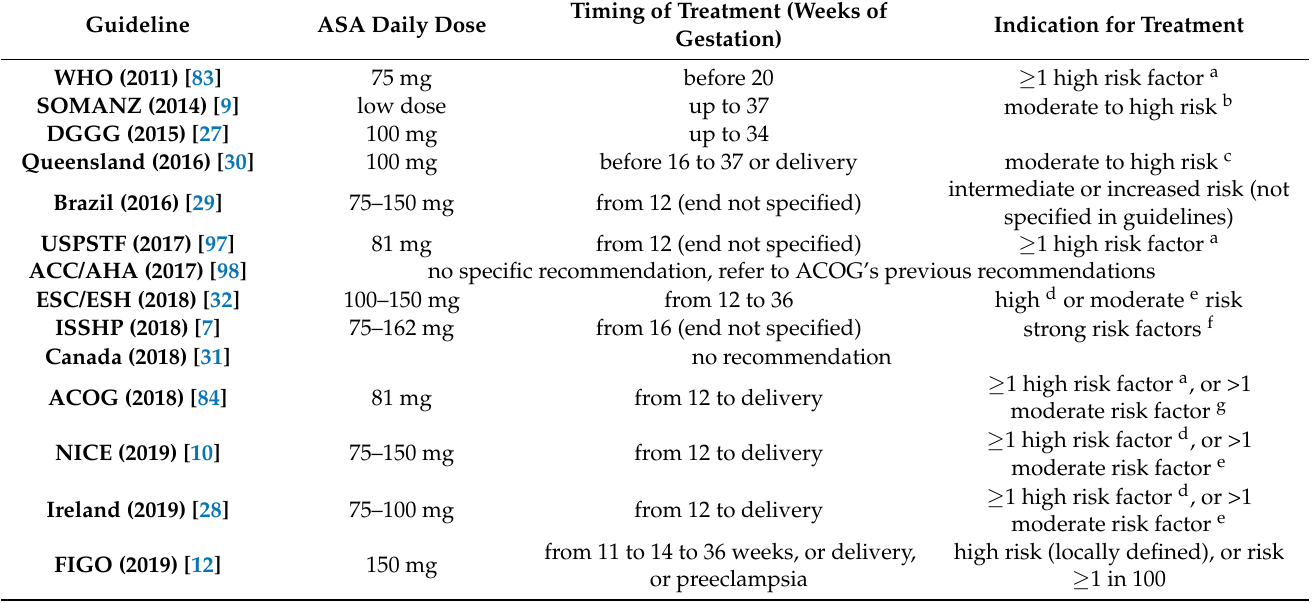
Table 5. Indications for the administration of acetylsalicylic acid (ASA) in preeclampsia prevention, as found in national and international